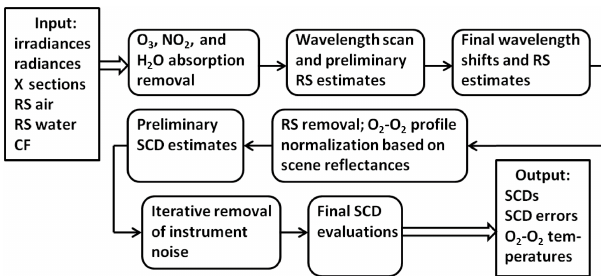
Figure 1. Flow diagram of the O 2 -O 2 SCD retrieval algorithm. The algorithm input comprises the OMI monthly mean solar irradiances; the radiances (dependent on wavelength, line of sight (row), and po- sition (along orbit)); the laboratory cross sections of O 3 , NO 2 , and H 2 O (X sections); the atmospheric (RS air) and liquid-water (RS water) Raman scattering spectra (all X sections convolved with the row- and wavelength-dependent OMI instrument line-shape func- tions); and the OMI cloud-fraction (CF) estimates provided by an independent retrieval. RS denotes the amplitudes of the combined air and water Raman scattering spectrum.